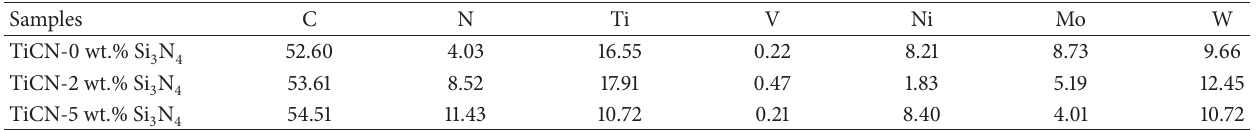
Figure 2: Typical BSE SEM images on polished surface of the as-prepared samples with different amounts of Si 3 N 4 nanopowder: (a) 0wt.%, (b) 2wt.%, and (c) 5wt.%. Table 3: Typical atomic content of each element in Particle